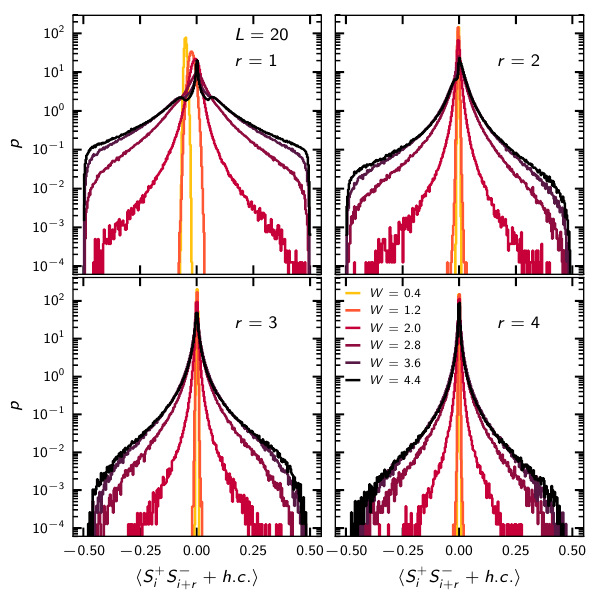
| n 〉 for dis- i , i + r